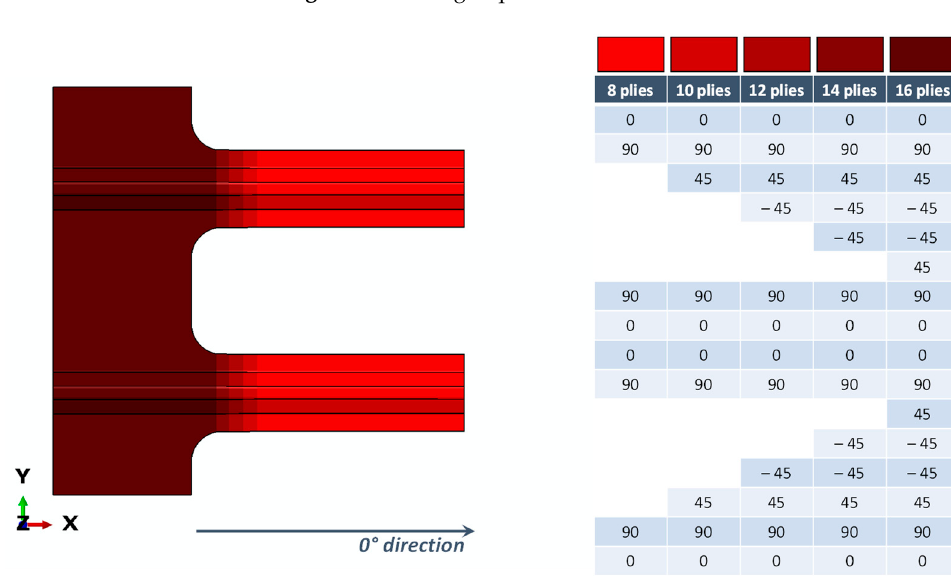
Figure 4. Stacking sequences in the stringers.